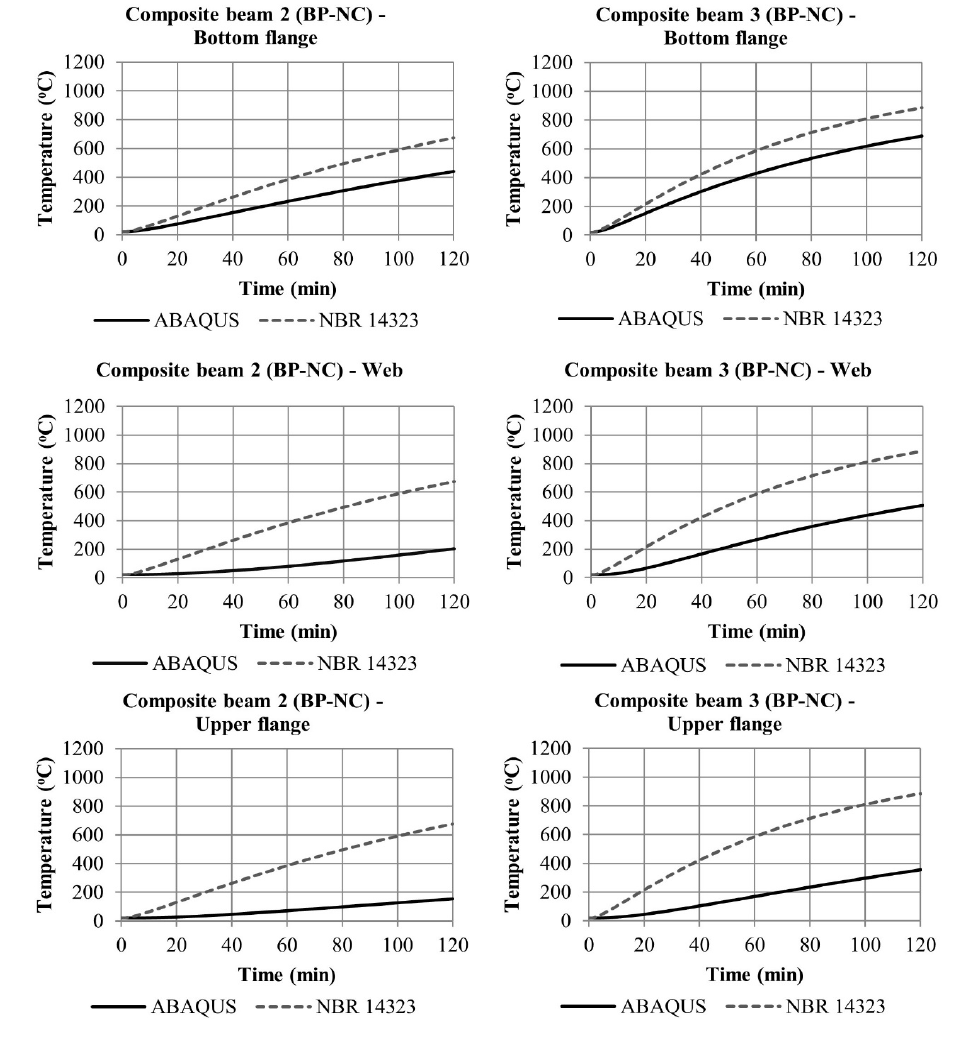
Figure 12. “Temperature x time” curves obtained by the simplified method and by the advanced calculation method for the profiles of composite beams 2 (BP-NC) and 3 (BP-NC).